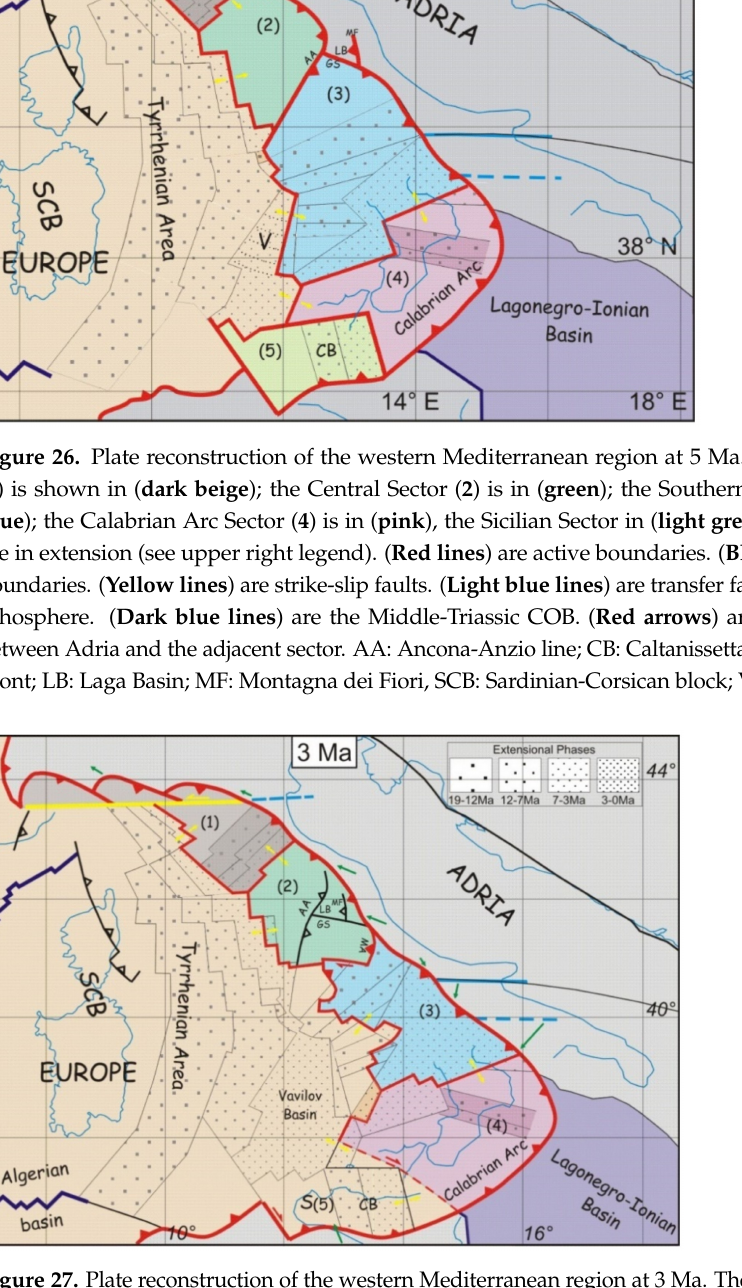
Figure 27. Plate reconstruction of the western Mediterranean region at 3 Ma. The Northern Sector ( 1 ) is shown in ( dark beige ); the Central Sector ( 2 ) is in ( green ); the Southern Sector ( 3 ) is in ( light blue ); the Calabrian Arc Sector ( 4 ) is in ( pink ), the Sicilian Sector in ( light green ) ( 5 ). ( Dashed lines ) are incipient boundaries ( Dotted areas ) are in extension (see upper right legend). ( Red lines ) are active boundaries. ( Black lines ) are inactive boundaries. ( Yellow lines ) are strike-slip faults. ( Light blue lines ) are transfer faults on the continental lithosphere. ( Dark blue lines ) are the Middle-Triassic COB. ( Green arrows ) are the velocity vectors between Adria and the adjacent sector. A-A: Ancona-Anzio line; CB: Caltanissetta Basin, GS: Gran Sasso Front; LB: Laga Basin; MA: Maiella Front; MF: Montagna dei Fiori; S: Sicily; SCB: Sardinian-Corsican block, TL: Taormina